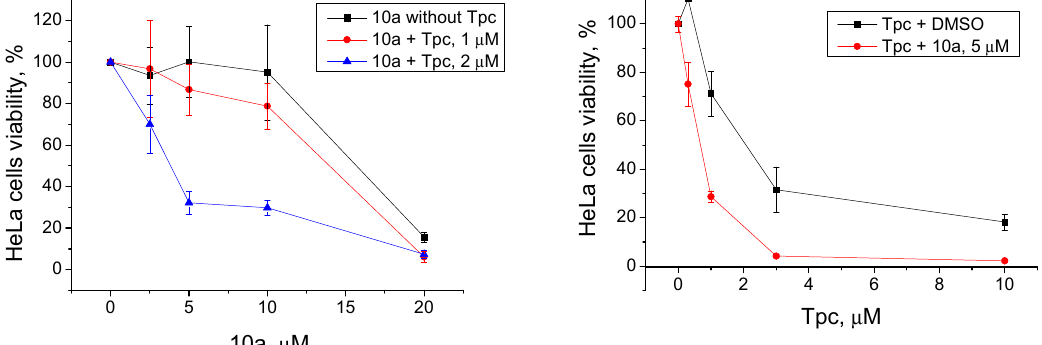
Figure 5. Left panel: The influence of Tpc at 1 μ M and 2 μ M concentrations on 10a cytotoxicity. B: The influence of the 10a derivative at a 5 μ M concentration on Table 1. DMSO, for the red curve on the cells treated with 1 μ M topotecan and 1% DMSO, and for the blue curve on the cells treated with 2 μ M topotecan and 1% DMSO, in order to exclude the effect of topotecan itself and see the effect of the drug combination. Right panel: cells treated with 1% DMSO (black line) or 5 μ M 10a (red line) were taken as 100% in order to evaluate the effect of the combination rather than the individual substance 10a .